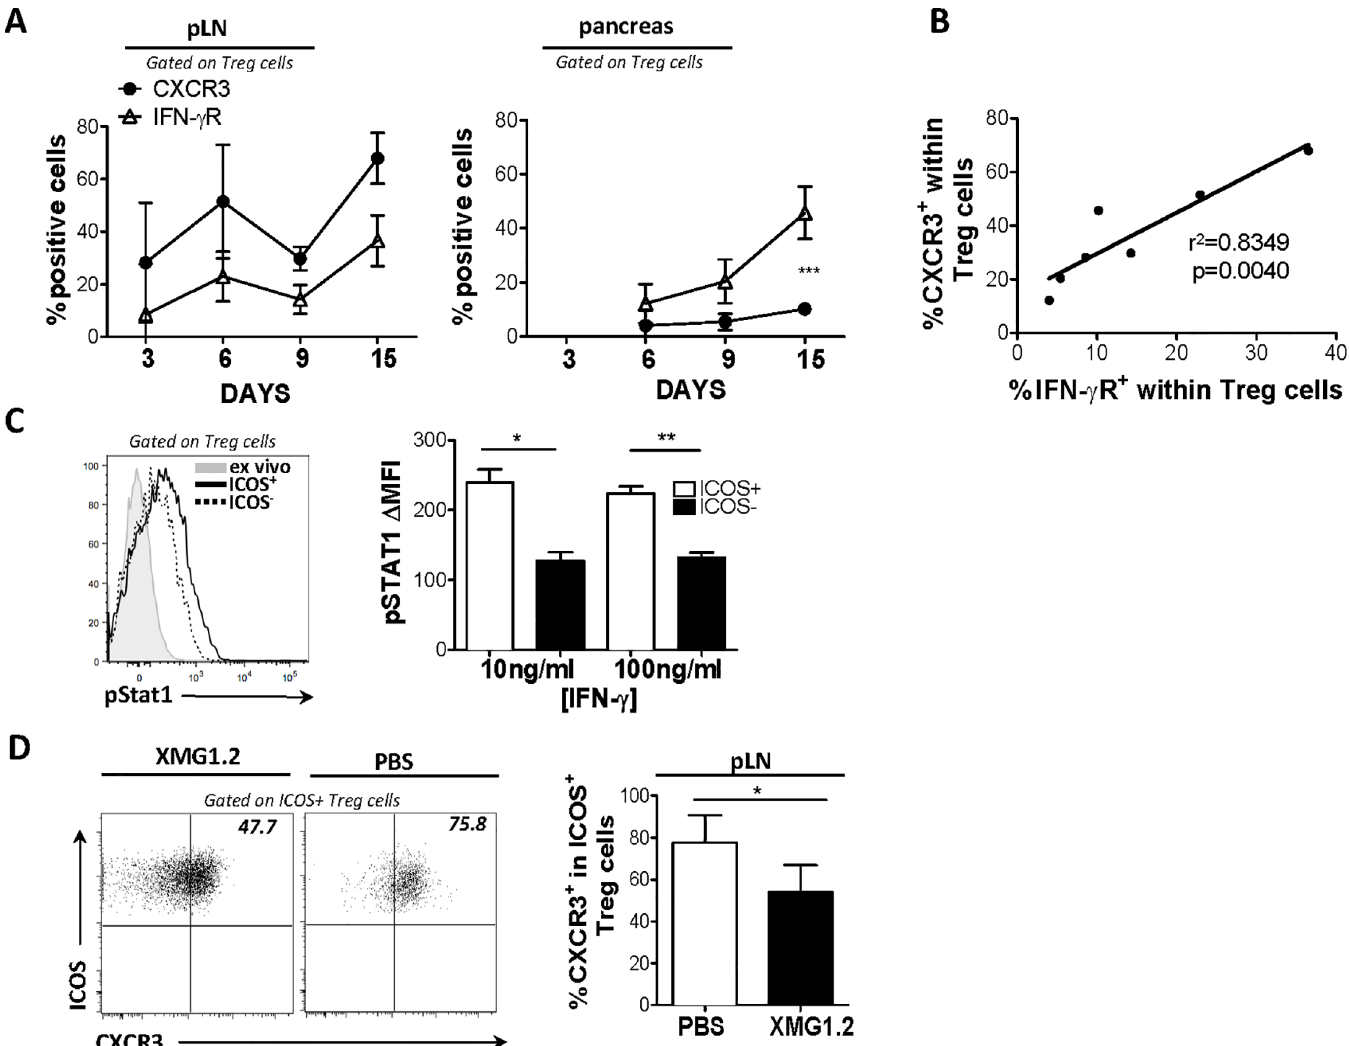
Fig 6. IFN- γ regulates CXCR3 expression by ICOS + T reg cells and their homing to islets. NOD.TCR α -/- mice received BDC2.5 CD4 + T cells (7.5X10 5 ) and, (A) and the percent CXCR3 + and IFN- γ R + cells among total T reg cells in pancreas and draining LNs was assessed at the indicated times post-transfer. (B) Correlation between percent CXCR3 + and IFN- γ R + in pancreas and draining LN at all points examined. (C) BDC2.5 CD4 + T cells were stimulated with various concentrations of recombinant IFN- γ , and STAT1 phosphorylation was assessed by flow cytometry and compared between ICOS + and ICOS